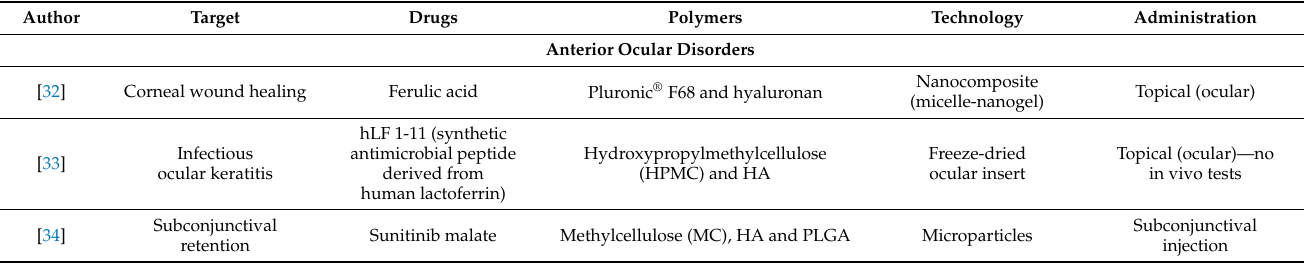
Table 1. List of papers regarding polymer blends found from the search for polymeric drug delivery systems for ophthalmic use in the databases Pubmed and